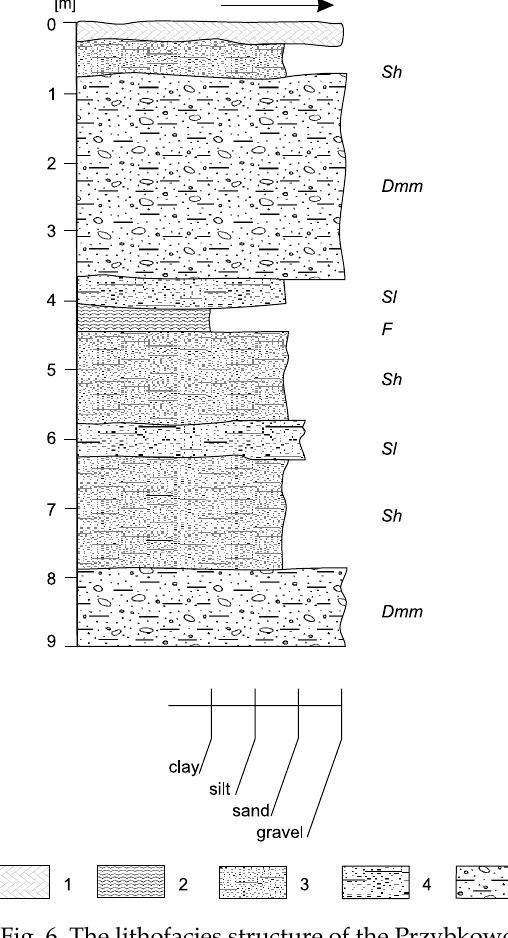
Fig. 6. the lithofacies structure of the Przybkowo/ Barwice site. 1 – soil, 2 – clay, 3 – fine-grained sands with horizon- tal lamination, 4 – fine-grained sands with trough cross-stratification, 5 – massive